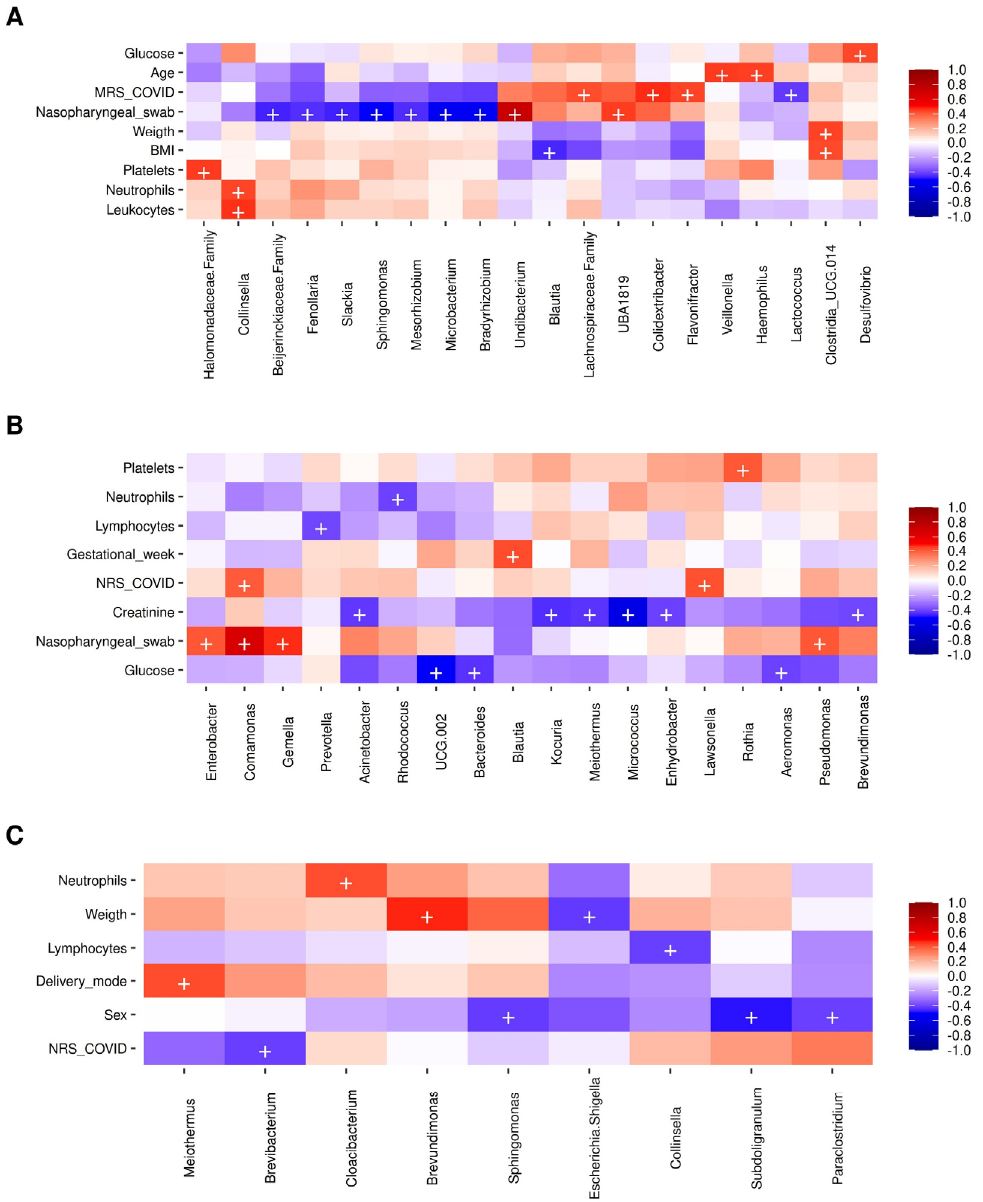
Figure 6. Spearman correlation analysis of clinical metadata and other variables, with bacterial abundance. ( A ) MRS (mother rectal swab); ( B ) HC (human colostrum), and ( C ) NRS (neonate rectal swab). The heatmaps show correlations between different bacterial taxa and numerical metadata. Columns show the bacterial taxa, while rows show the numerical metadata. The color keys from blue ( − 1, negative) to red (+1, positive) measure the correlation. The plus symbol “+” denotes a significance of p < 0.001. For the “Sex” variable, the blue color indicates a correlation of the bacteria with male children; for the “Delivery mode” variable, the red color indicates a correlation with vaginal delivery. Two MRS, two HC, and four NRS samples were not included in these analyses since they lacked suitable metadata.